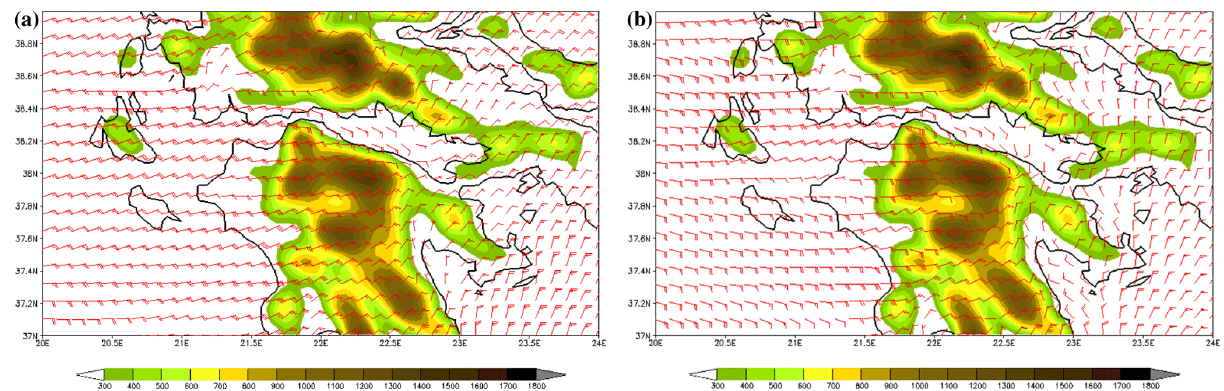
Fig. 9. 10m wind speed from MM5 model valid at ( a ) 06:00UTC on 26 December 2011 and ( b ) 18:00UTC on 12 January 2009. A full barb corresponds to 5ms − 1 . Colored shading shows the terrain heights exceeding